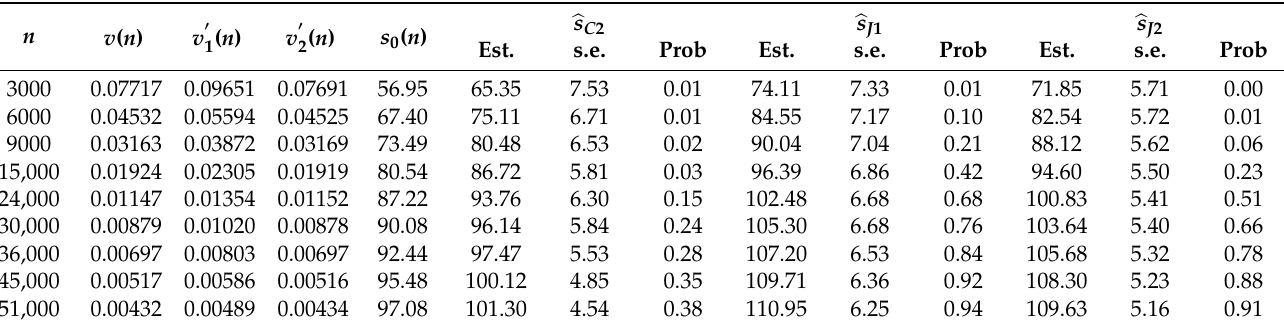
Table 3. Taiwan’s Bird Data (Numbers of species in two populations are s 1 = 155 & s 2 = 149 and the number of shared species is s 0 = 111; J 1 & J 2: 1st & 2nd Jackknife estimates, C 2: Chao’s estimate, s 0 ( n ): number of observed shared